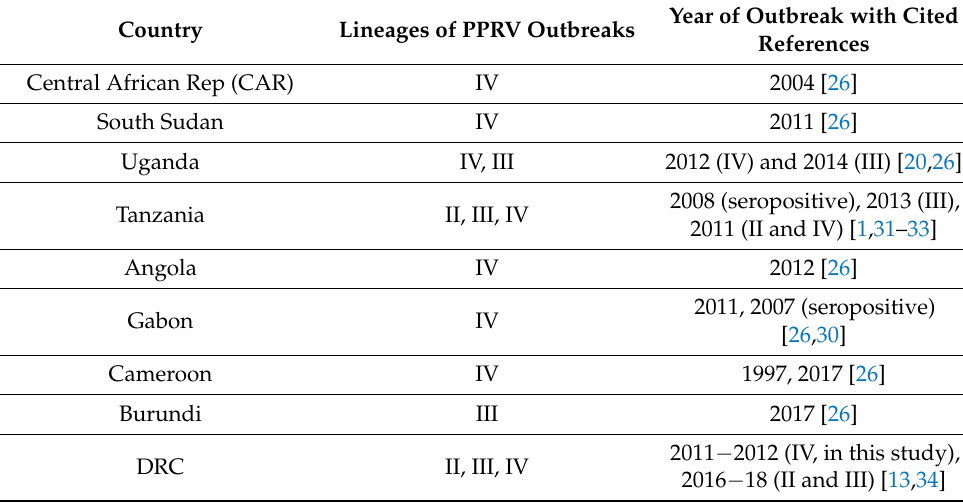
Table 2. List of PPRV lineages circulating in the DRC and neighboring